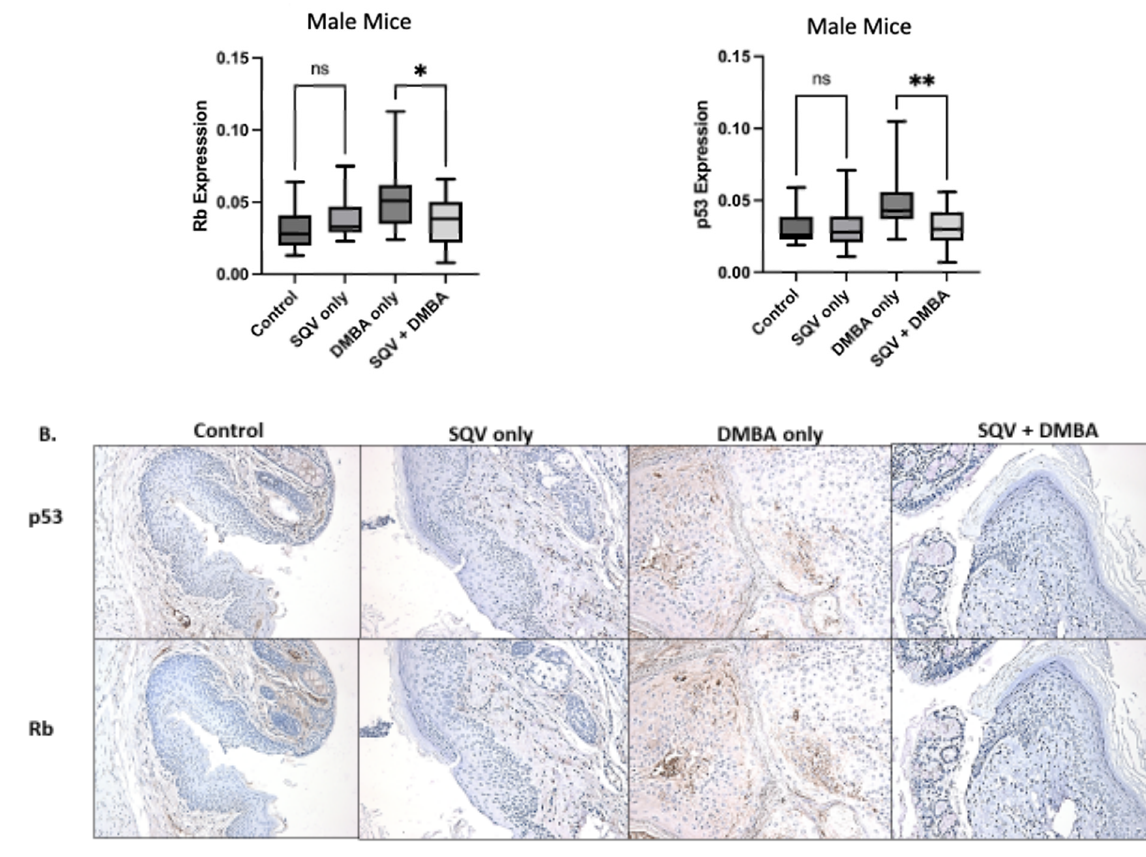
Figure 5. Expression of Rb and p53: ( A ) Quantification of Rb and p53 expression in each treatment group and separated by sex; ( B ) Representative images of immunohistochemically stained anal tissue from mice in each treatment group for Rb and p53. Significance was assessed as * p < 0.05, ** p < 0.01, and “ns” is not significant.